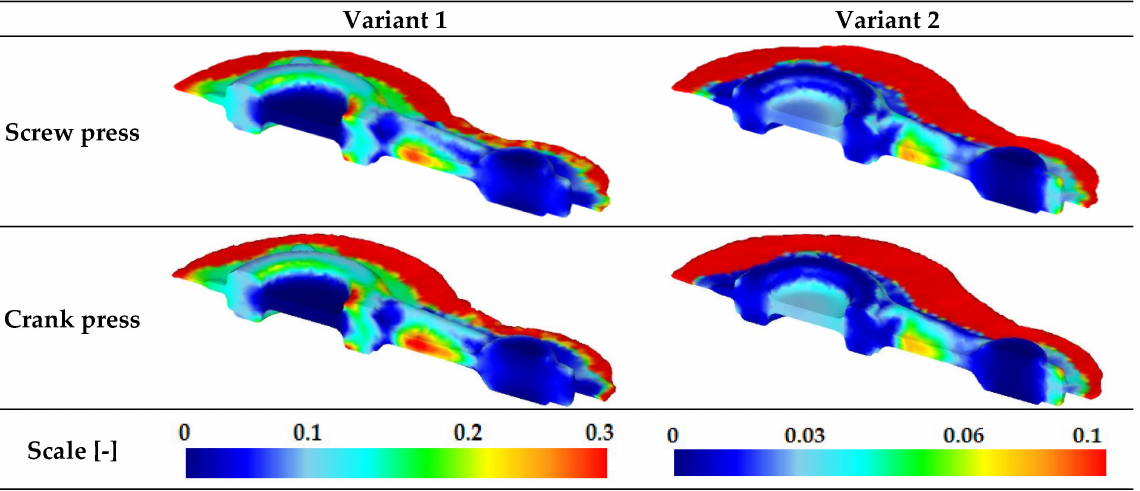
Figure 21. Distribution of Cockcroft–Latham integral values for connecting rod forgings made of AB-71100 alloy formed based on the new technology.